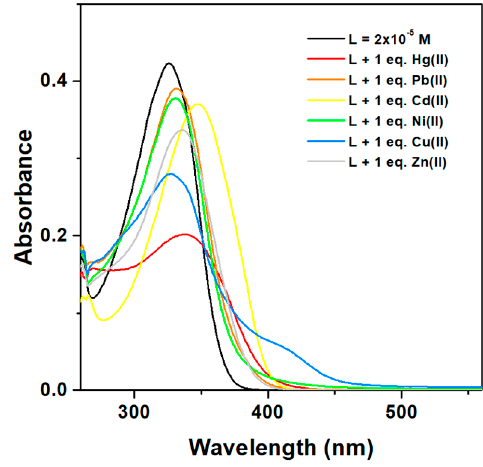
Figure 1. UV-VIS spectra of ligand L before and after the addition of 1 equivalent of heavy metal ions.